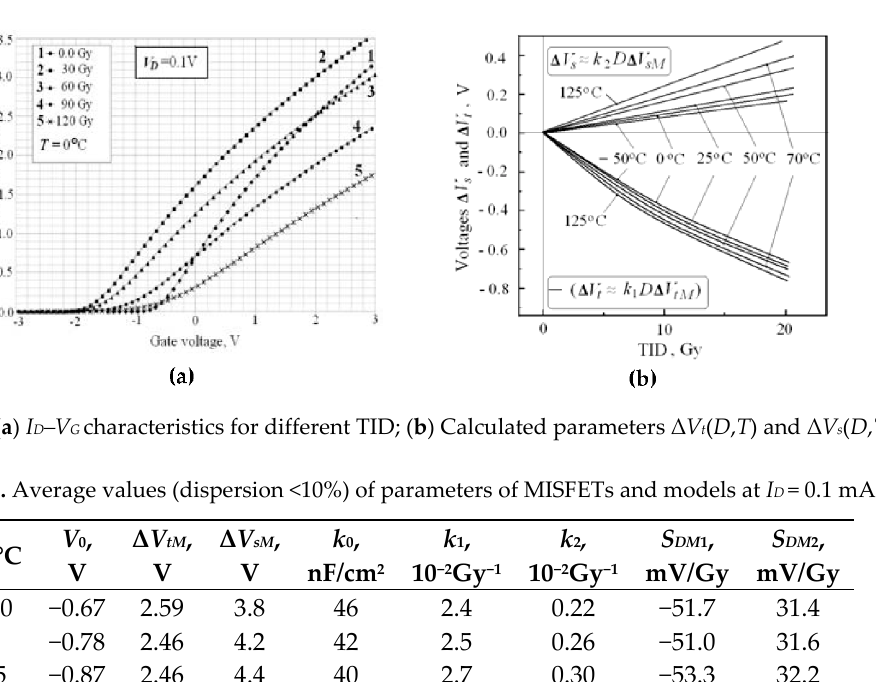
Figure 3. ( a ) Conversion functions at different I D ; ( b , c ) Conversion functions at different temperatures T .